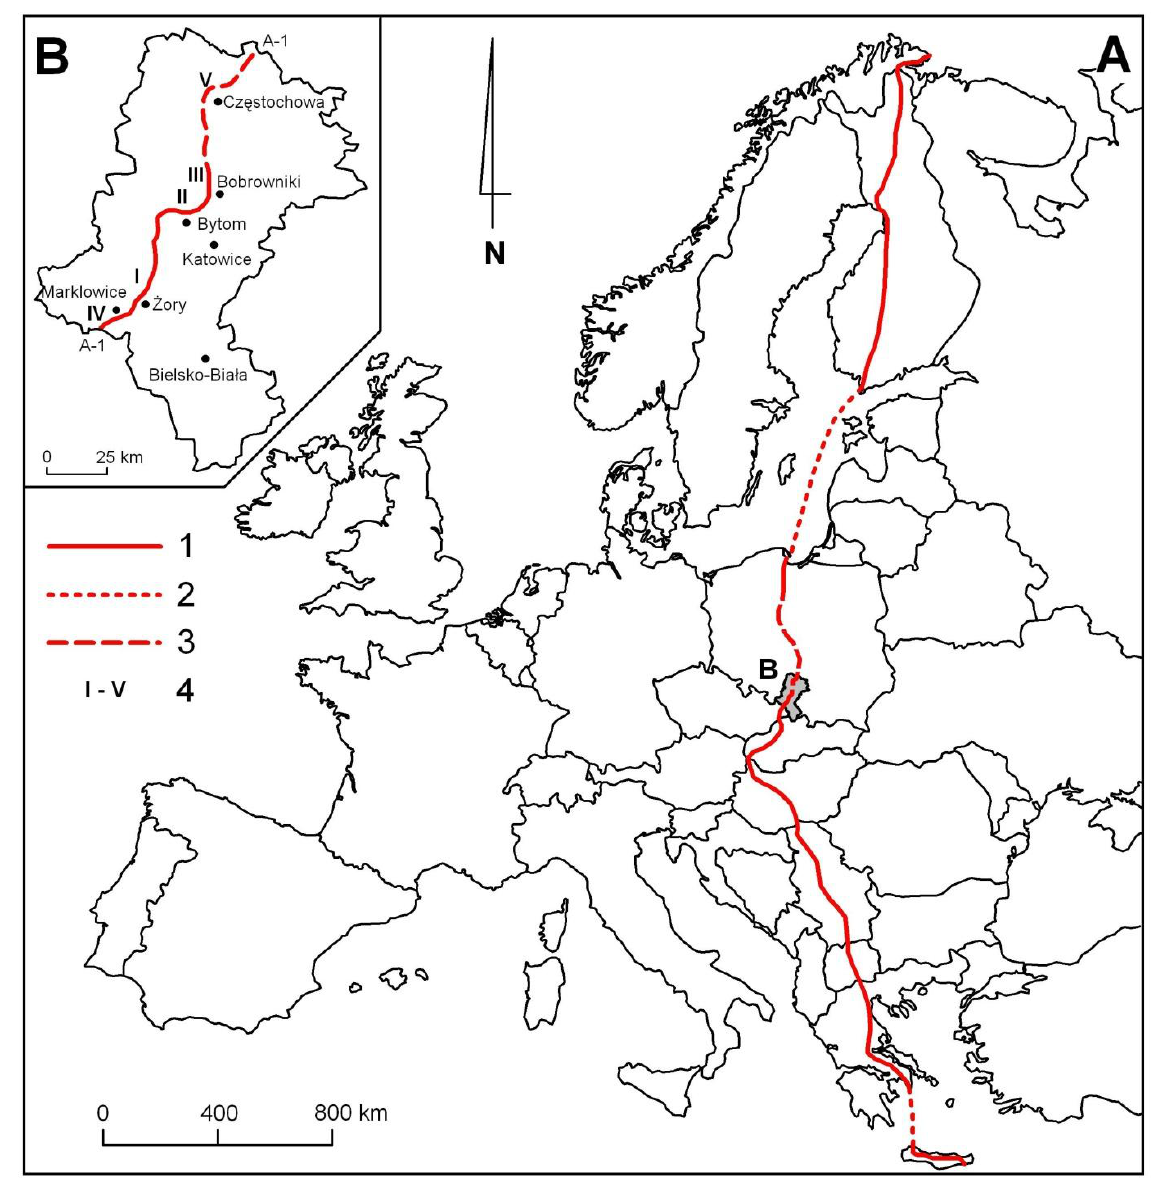
Fig. 1. The A1 motorway in Poland as a part of the international route E75 (A); The A1 motorway in the Silesian voivodeship (B) 1 – motorway open; 2 – ferry; 3 – motorway construction; 4 – places of social conflicts caused by construction of the A1 in the Silesian voivodeship (numbering in the figure corresponds to the description in the text)